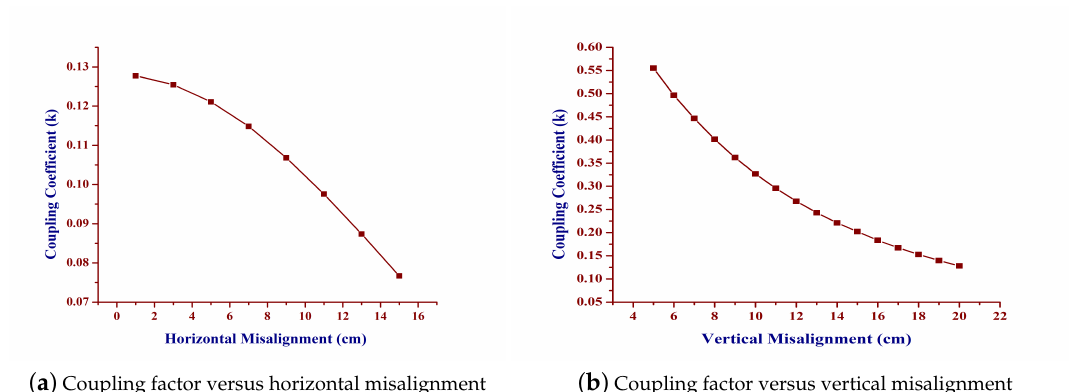
Figure 7. Coupling factors for various misalignments.